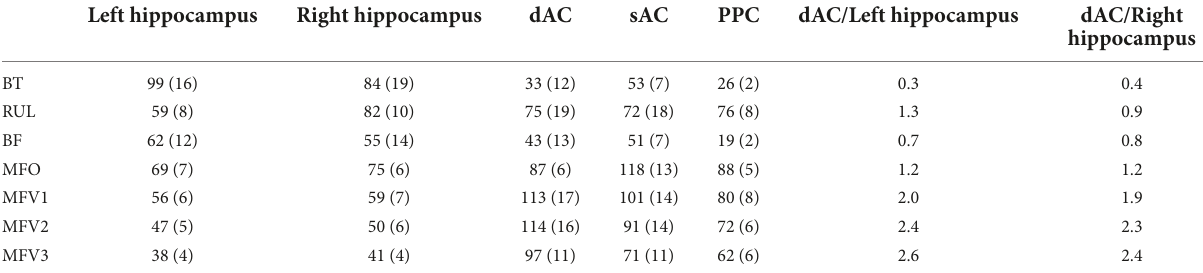
TABLE 1 Electroconvulsive therapy (ECT)-induced electric fields in V/m (standard deviation) for different electrode placements sampled within specific regions of interest (ROI). Left hippocampus Right hippocampus dAC sAC PPC dAC/Left hippocampus dAC/Right